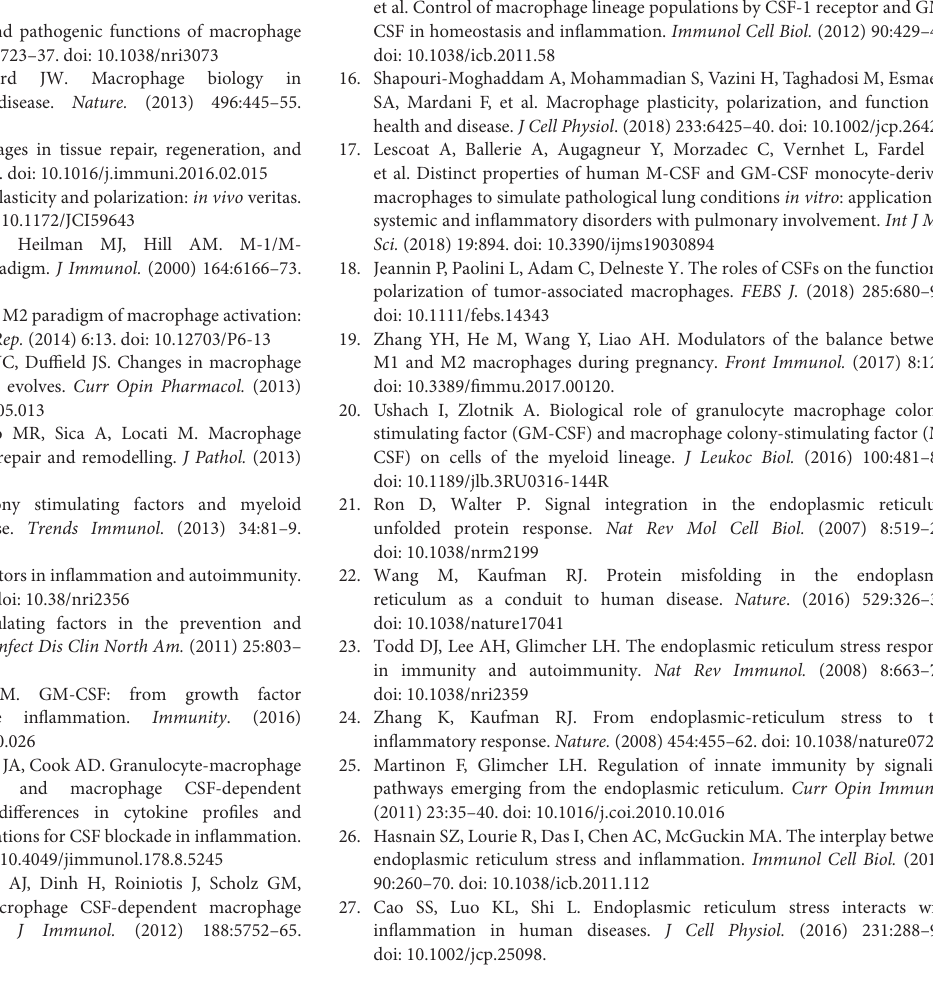
Figure S3 | Cellular stress amplifies TLR4 induce cytokine expression in BMDM. (A–C) M-BMDM and GM-BMDM were treated with DMSO or Tm (1 µ g/ml) for 6h prior to stimulation with LPS (100ng/ml) for the indicated times. Levels of TNF α (A) , CXCL1 (B), or IL6 (C) mRNA were determined by real time PCR and presented as described in Materials and Methods. Data are presented as the mean ± SD for triplicate experiments and the differences between DMSO and Tm treatments were evaluated by two way-ANOVA and Turkey’s multiple comparisons test. P < 0.05 is indicated by ∗ for comparison of stress vs. DMSO in M-BMDMs, by # for comparison of stress vs. DMSO in GM-BMDMs, by ※ for comparison of M DMSO vs. GM DMSO and by 9 for comparison of M-BMDM stress vs. GM-BMDM DMSO. Figure S4 | Liver injury induced by APAP administration. (A) WT mice were injected i.p. with APAP (300 mg/kg) for 24 or 72h and treated with DMSO or Tm i.p. during the final 18h. The blood was collected for the measurement of ALT activity as described in Materials and Methods. (B) WT mice were treated with APAP only as in (A) , and the representative images of H&E-stained liver sections 24, 48, and 72h post APAP challenge are shown ( n = 5). Data are presented as the mean ± SD of triplicate experiments and the differences between indicated treatments were evaluated by two way-ANOVA and Turkey’s multiple comparisons test. P < 0.05 is indicated by ∗ for comparison of the indicated